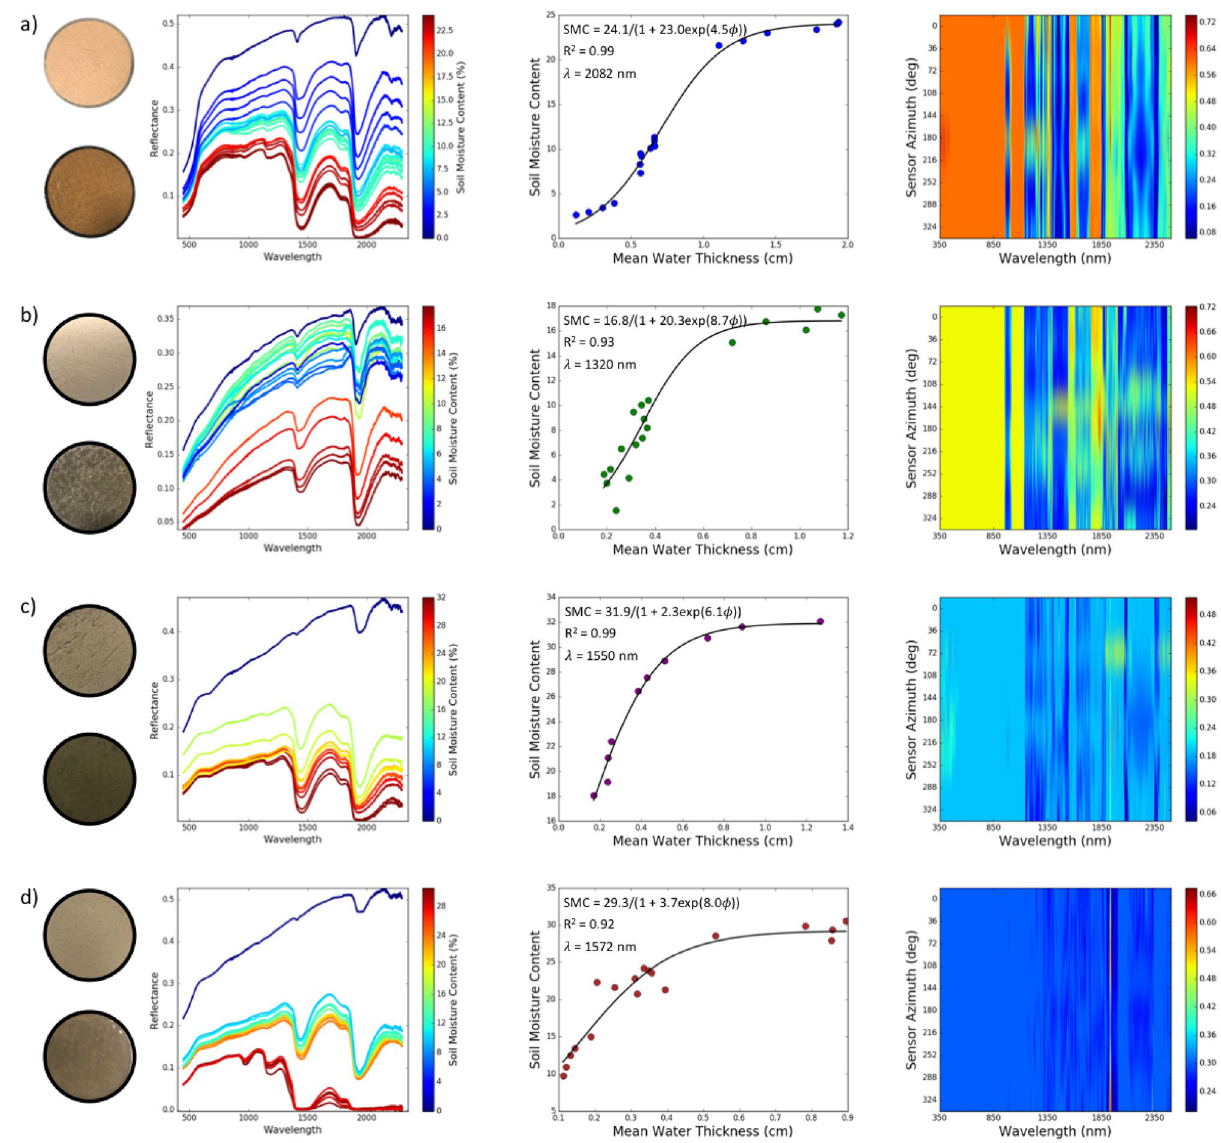
Figure 1. (First column) Photos of dry (top photo) and wet (bottom photo) soil samples for the four sites: ( a ) Algodones, ( b ) Nevada, ( c ) Hog Panne, and ( d ) Hog Beach. (Second column) Corresponding spectral reflectance plots of the four types of sediments at a sensor orientation with zenith angle = 0 ◦ and relative azimuth angle (to the light source) = 36 ◦ over a progression of moisture levels; color of reflectance curves corresponds to moisture level (right colorbar of each plot). (Third column) Best model fit found, over all possible combinations of wavelength and sensor zenith/azimuth orientations, relating SMC and mean water 2 thickness (range of NRMSE = 0.044–0.145 and regression coefficient of determination 28 , R = 0.92–0.99). (Fourth column) NRMSE of all models as a function of sensor relative azimuth and wavelength with color key representing the error each of the different soils. The best fit obtained depended on the sample: 2082 nm, 1320 nm, 1550 nm, and 1572 nm for the ALG, NEV, HOGP and HOGB soil samples respectively. For these wavelengths, the accuracy of the fit was very high with normalized root mean square error (NRMSE) in the range NRMSE < 0.145 ; in this work, we define NRMSE to be the ratio of mean squared error to mean measured value 29,30 , also sometimes referred to 1 N 2 i = 1 ( SMC i , pred − SMC i , gt ) N (cid:30) as the “Scatter Index” 29,31 , in a given bootstrap trial: NRMSE = (cid:31) , where SMC i , pred and SMC SMC i , gt represent respectively the model prediction and measured (ground truth) values of the SMC for the ith sample in the specific bootstrap test and SMC represents the average ground truth SMC value over the same set of bootstrap samples. While these were the best wavelength models found in each case, there were several wave- lengths where the NRMSE was relatively low in the SWIR range, so that good model fits could be obtained for more than one wavelength. In contrast, the accuracy of the fit between SMC and mean equivalent water thick-